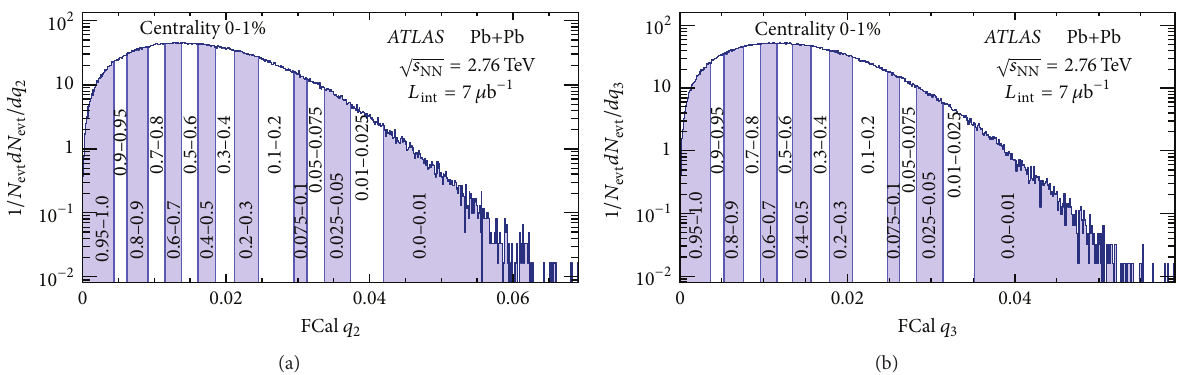
Figure 2: Distributions of 𝑉 2 (a) and 𝑉 3 (b) calculated with ATLAS forward calorimeter for centrality interval 0-1%. Figures are taken from